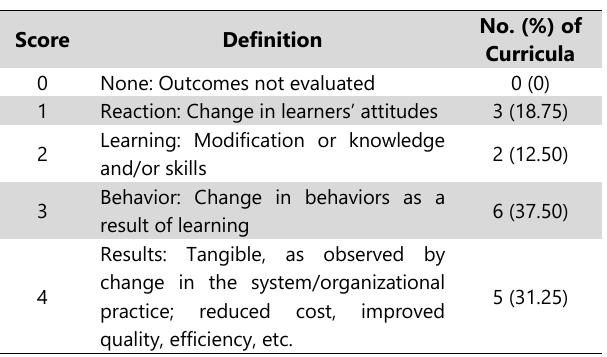
Table 2 . Inclusion and Exclusion Criteria.